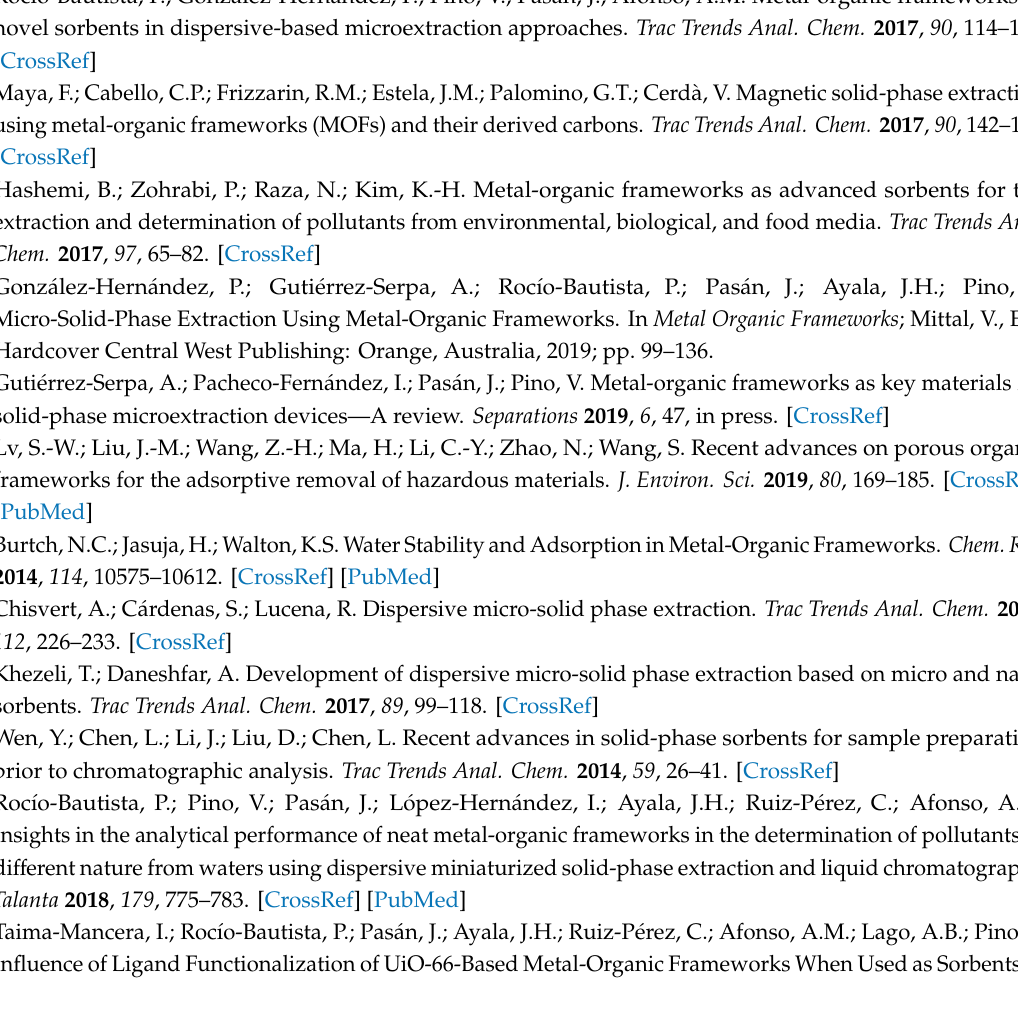
Supplementary Materials: The following are available online, Figure S1: Scheme of the D- µ SPE-HPLC-DAD method using optimum conditions; Figure S2–S4: XRD patterns; Figure S5, S6: Infrared spectra; Figure S7–S9: Analytical performances; Table S1: Adsorption data for all the synthesized UiO-66-based MOFs; Table S2: Elemental analysis data for all the synthesized UiO-66-based